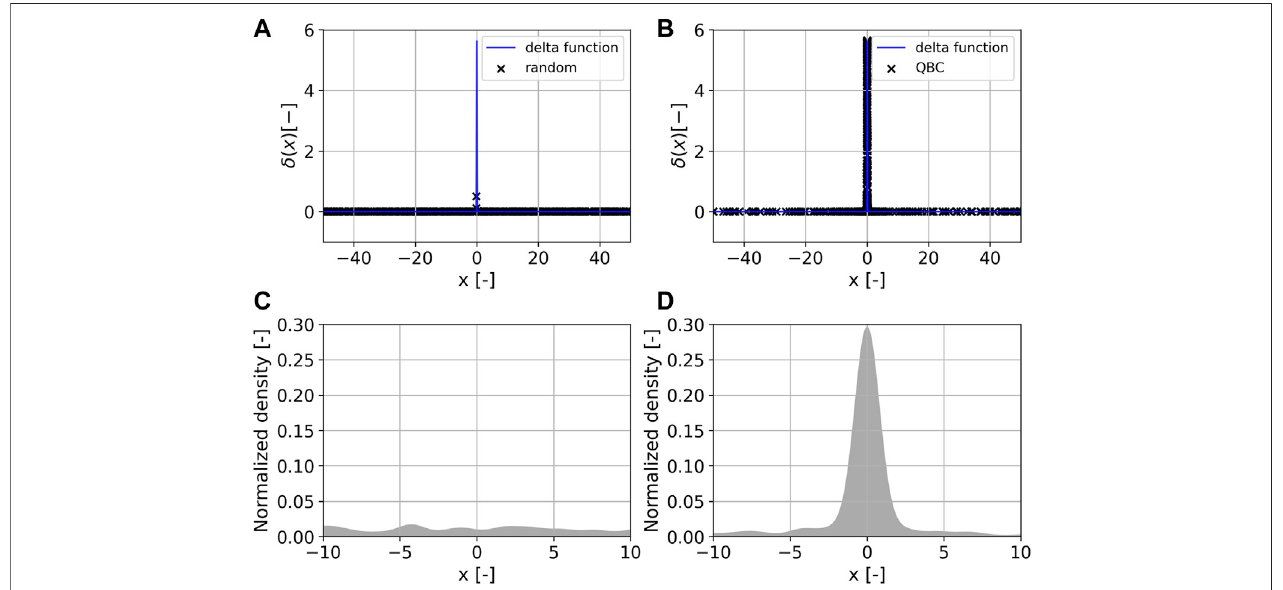
FIGURE 3 | The sampled input-output space of the approximated Dirac delta function δ ( x ) is shown above. 500 samples were generated via random sampling (A) and query-by-committee, labeled as QBC, (B) . Below, the normalized Gaussian kernel density estimation isshown for the data sets generated via random sampling (C) and query-by-committee (D)